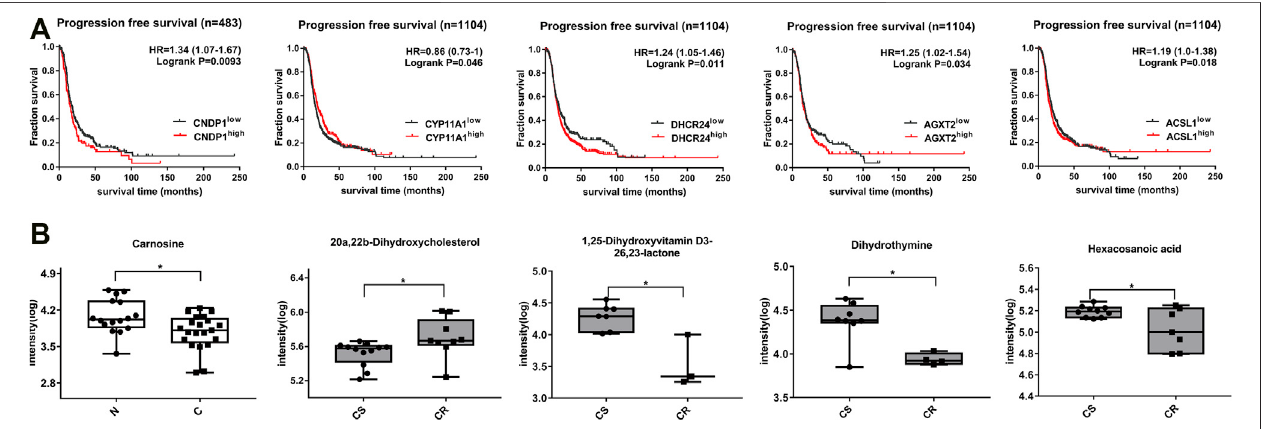
FIGURE 4 | Expression of differential metabolites and correlation between related enzyme genes and progression-free survival of patients. (A) Progression-free survivalcurveofdifferentialmetabolites( p < 0.05). (B) Boxplotsofcorrespondingmetabolitebiomarkersinnon-chemotherapygroupvschemotherapygroup(blank)and chemotherapy-sensitive group vs chemotherapy-resistant group (gray) ( p <